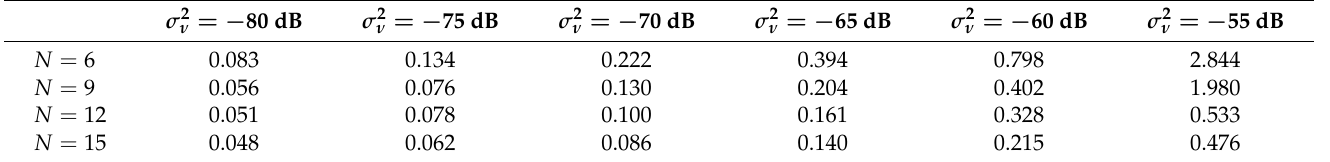
Table 7. Mean error (in meters) of the Grid Search (0.1 m